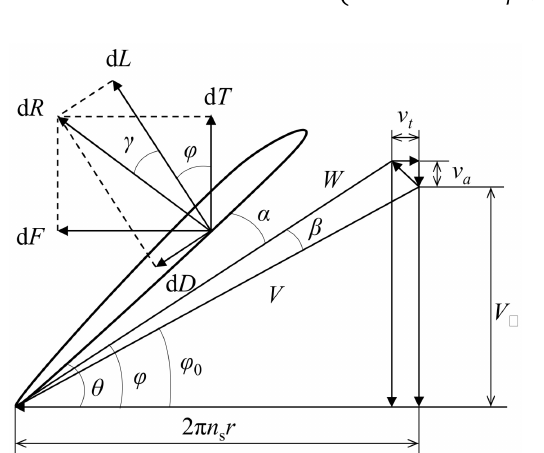
Figure 10. Force diagram for a blade